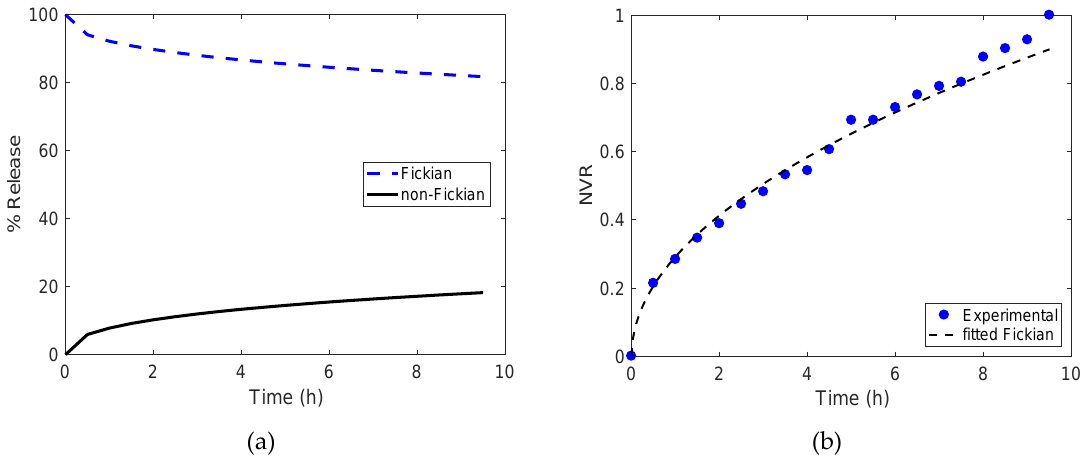
Figure 5. ( a ) Fickian and non-Fickian release percentages for riboflavin corresponding to sample with pH 4 when anomalous transport mechanism was considered. ( b ) Predicted release curve for encapsulated riboflavin at pH 4 considering pure Fickian mechanism and estimated D app (dash –) compared to experimental curve (blue